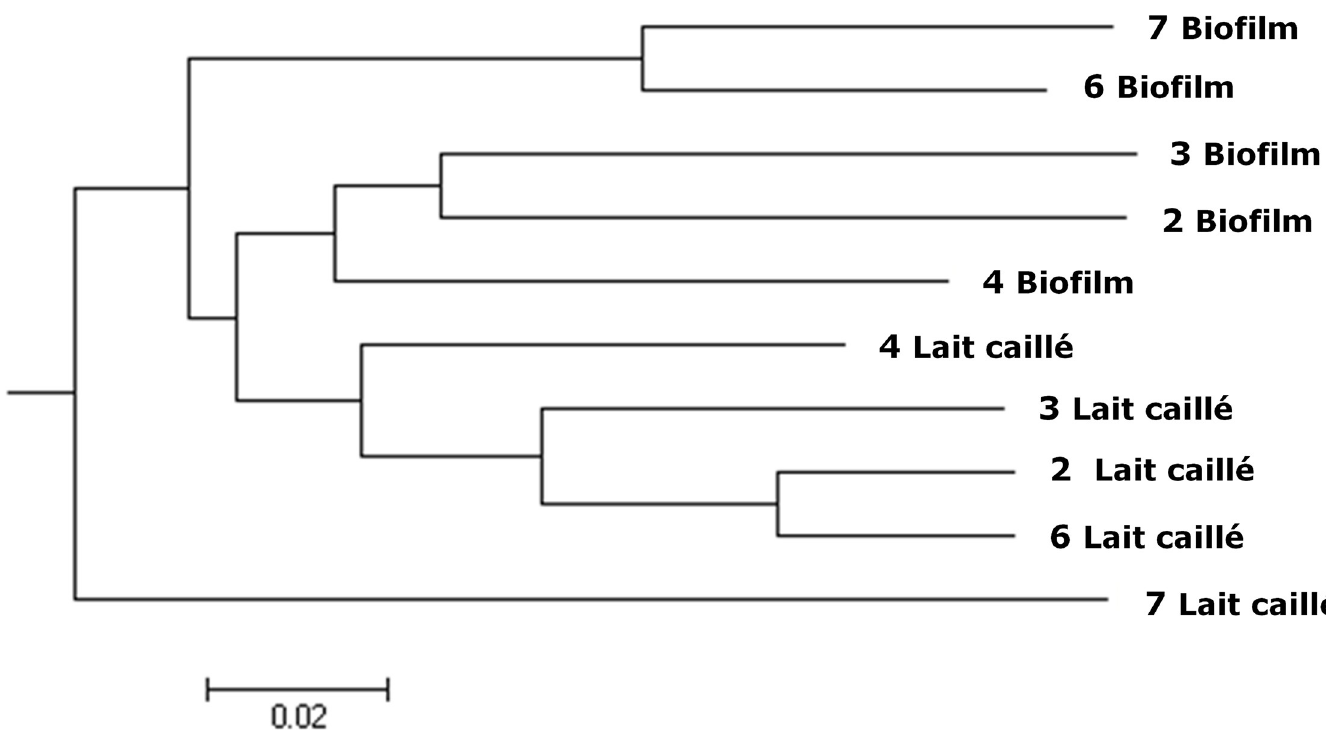
Fig 2. Hierarchical clustering of bacterial communities from lahal surface and lait caille´. Lahal surface samples as well as lait caille´ samples of lahal 2,3,4,6, and 7 are clustered using Unweighted Pair Group Method with Arithmetic Mean based on beta-diversity of the bacterial communities.